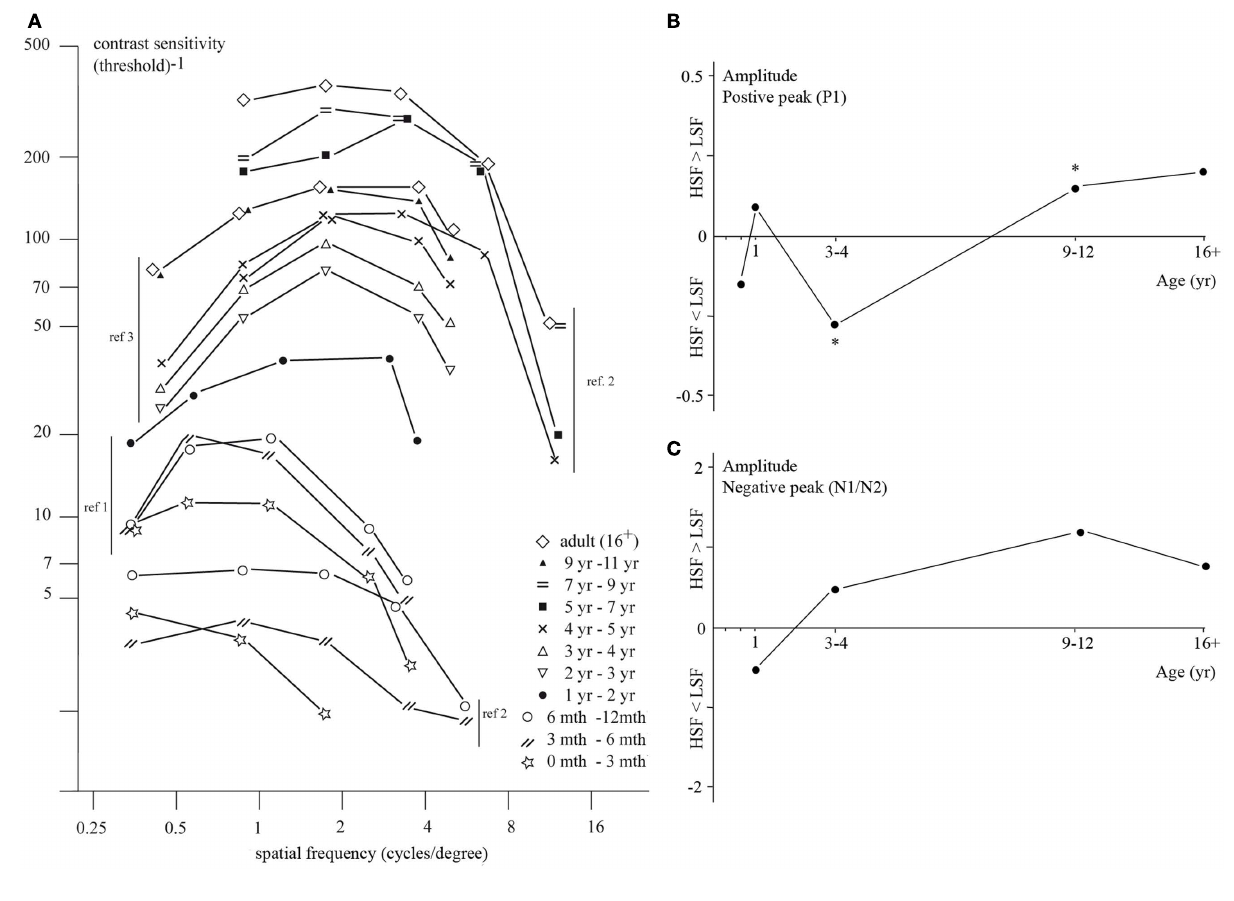
FIGURE 4 | (A) Contrast sensitivity function for different ages (symbols): contrast sensitivity as a function of stimulus spatial frequency. Numbers in figure reflect references; 1. Adams et al., 1992; 2. Gwiazda et al., 1997; 3. Adams and Courage, 2002. (B) Amplitude [relative value of amplitude evoked by high versus low SFs; calculated as (HSF − LSF)/HSF] of the positiveVEP peak (P1) at different age groups. (C) Amplitude [relative value of amplitude